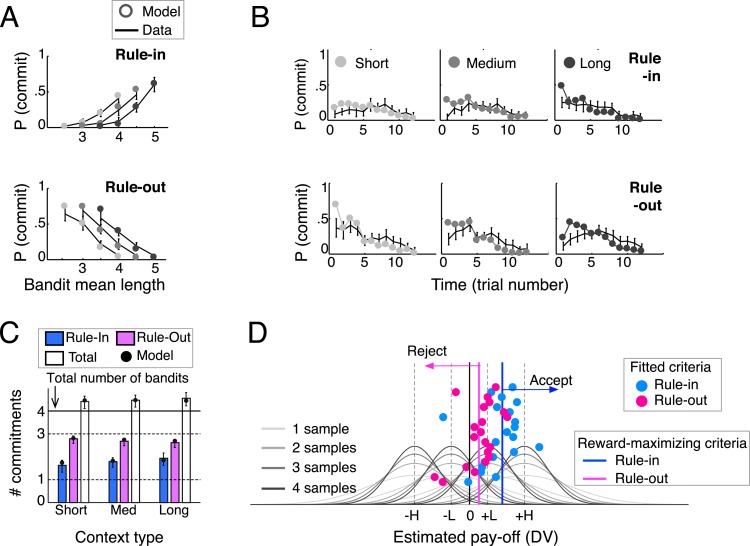
Behavioral results (N = 20) and model predictions.(A) Commitment probability in different contexts (short, medium and long blocks) as a function of mean bandit spiral length for rule-in (top) and rule-out blocks (bottom) and (B) probability of commitment as a function of trial number, context-type and rule. Black lines: human data; filled gray circles: model fits. (C) Mean number of commitments in rule-in and rule-out (and their sum), in the three different contexts. Moving from short to long contexts, commitments increased in rule-in (F(2,38) = 6.73, p < 0.01) and decreased in rule-out (F(2,38) = 4.95, p < 0.05). The model predicts this pattern (filled circles) by initializing the block reference to the mean spiral length in the experiment (see ‘Materials and methods’), thus over(under)-estimating the DV at trial 1 in long (short) contexts. The sum of commitments exceeded the number of available bandits (4.5 ± 0.6; t(19) = 3.64, p < 0.005), mainly due to more than one commitments made in rule-in. (D) Fitted decision criteria (filled circles) did not significantly differ from reward-maximizing criteria (solid vertical lines) under the current-minus-average model for rule-in (blue) and rule-out (purple). Gray curves show the distributions of the estimated pay-off for each of the four bandits under different numbers of samples (different shades). Values larger (smaller) than the rule-in criterion provoke inclusion by commitment (exclusion by deferral). Values smaller (larger) than the rule-out criterion result in exclusion by commitment (inclusion by deferral). Bars are 95% confidence intervals (C.I.). H and L stand for bandits with high and low absolute pay-off, respectively.